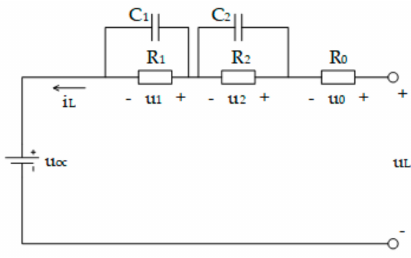
Figure 1. Double polarization (DP)